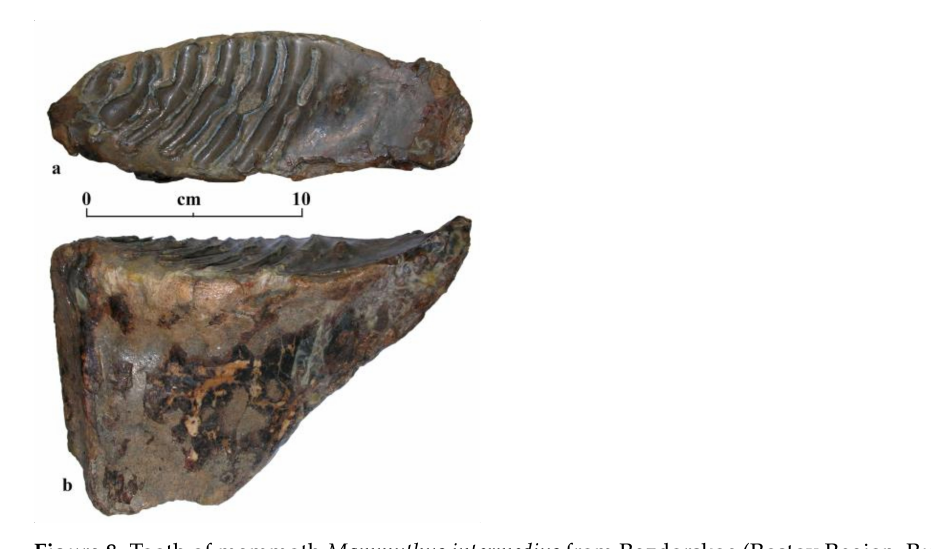
Figure 8. Tooth of mammoth Mammuthus intermedius from Razdorskoe (Rostov Region, Russia; the late Middle—early Late Pleistocene): ( a , b )—ROMK, no No., left m3, occlusal surface, lingual